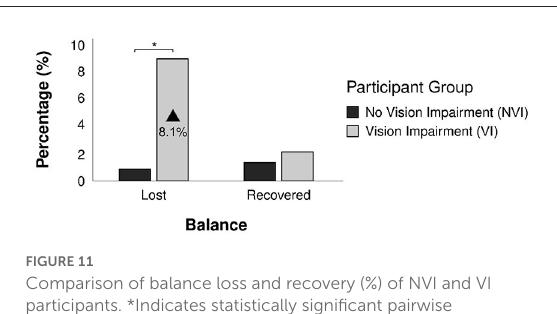
FIGURE11 Comparison of balance loss and recovery (%) of NVI and VI participants. *Indicates statistically significant pairwise comparisons for which p <